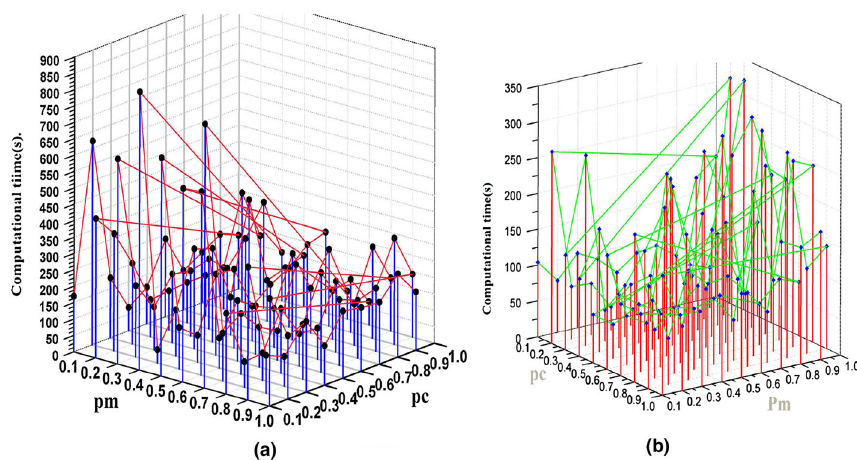
Fig. 7 Computational time with respect to pc and pm for problems 29PR144( a ) and 25PR124( b